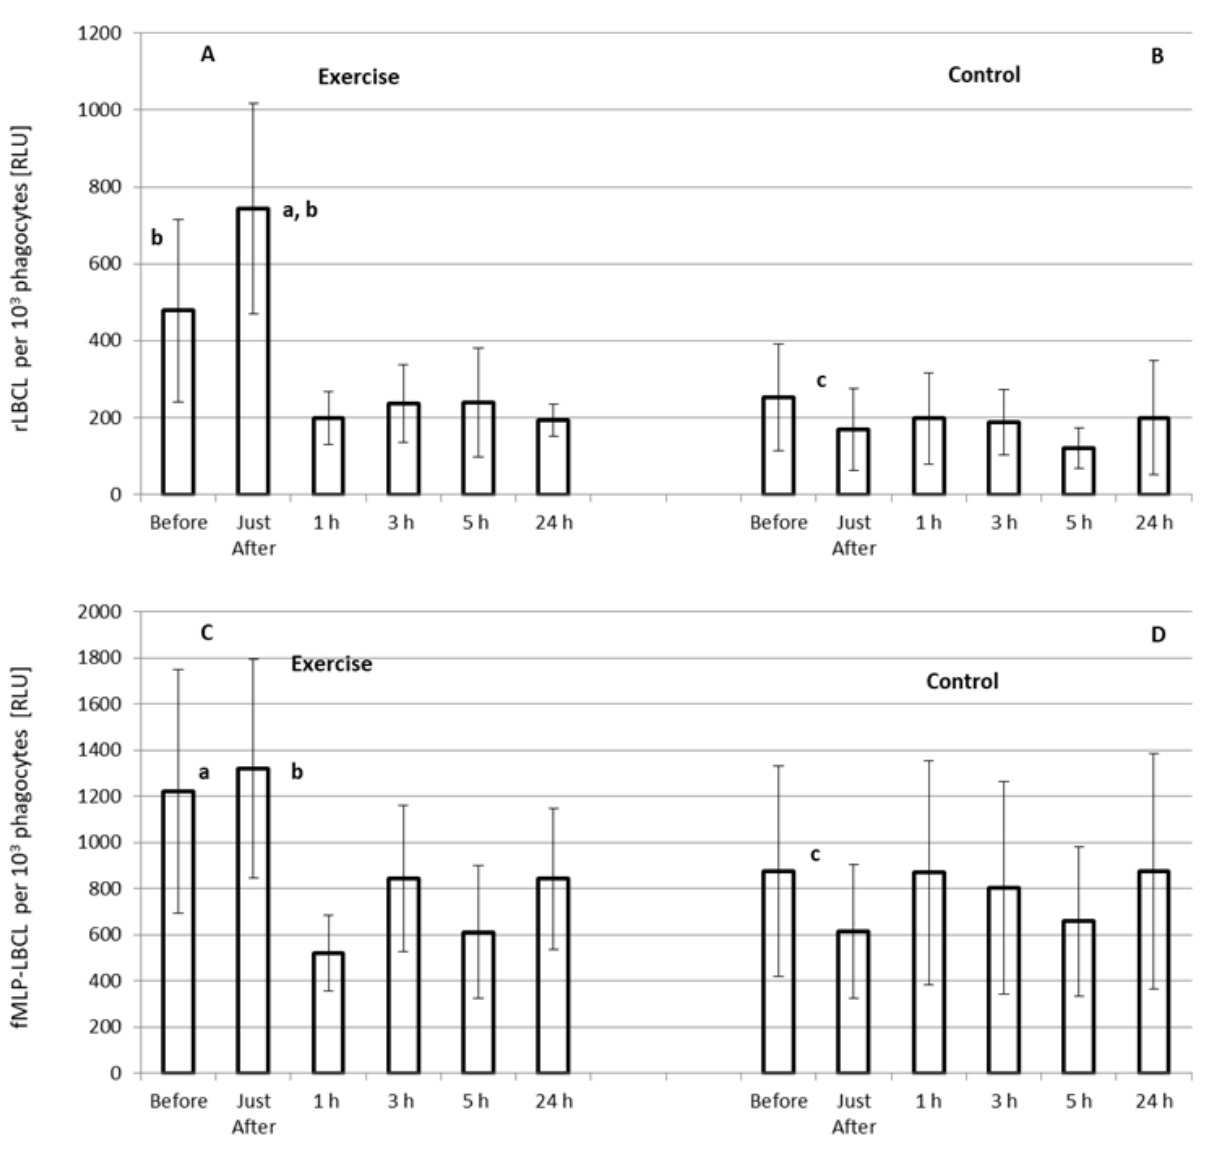
Figure 3. Effect of exhaustive treadmill run on rLBCL (resting luminol-enhanced whole blood chemiluminescence) ( A ) and fMLP-LBCL (N-formyl-L-methionyl-L-leucyl-L-phenylalanine–induced luminol-enhanced whole blood chemiluminescence) calculated per 10 3 phagocytes (neutrophils and monocytes) ( C ) in 18 amateur athletes. Blood was collected before, just after, and at 1 h, 3 h, 5 h and 24 h post-exercise. ( B , D ) and Other details as for Figure 2. a—vs. value before the exercise; b—vs. value at 1 h, 3 h, 5 h and 24 h post-exercise, and c—vs. corresponding value before the exercise, p <